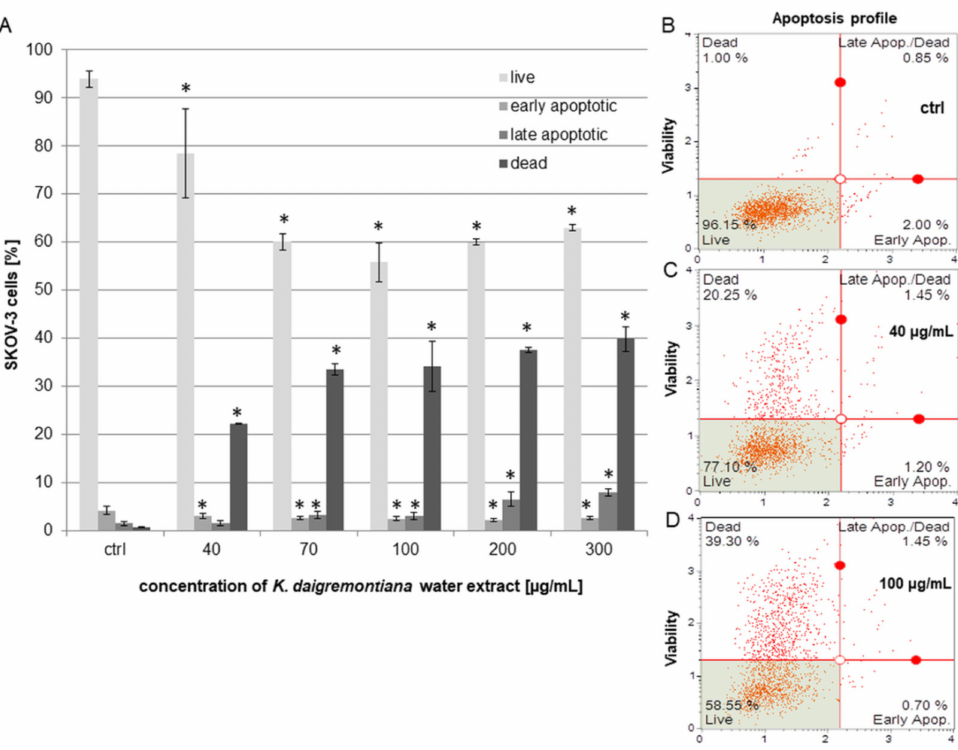
Figure 2. The effects of the water extract of K. daigremontiana on the viability of SKOV-3 cells. The estimation of the amount of each population (live, early apoptotic, late apoptotic, and dead cells) was performed with flow cytometry after 24 h of incubation of the cells with the extract ( A ). The values represent the means ± SD of three independent experiments. Error bars indicate standard deviations. Significant differences relative to the control are marked with an asterisk “*” (Student’s t -test, p < 0.05). The plots show the results after treating the cells with the extract concentrations of